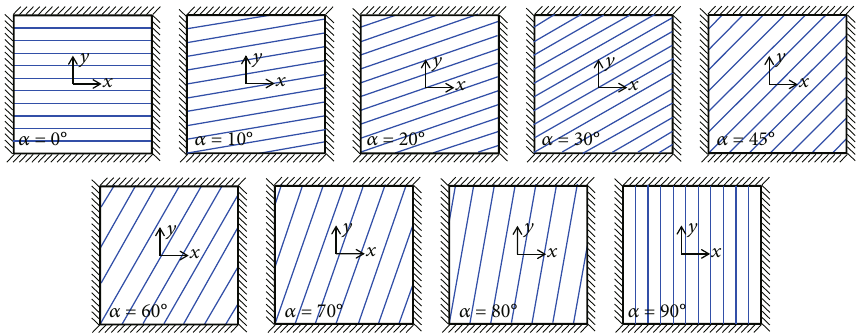
Figure 6: Schematic diagrams of di ff erent fracture direction model designs.